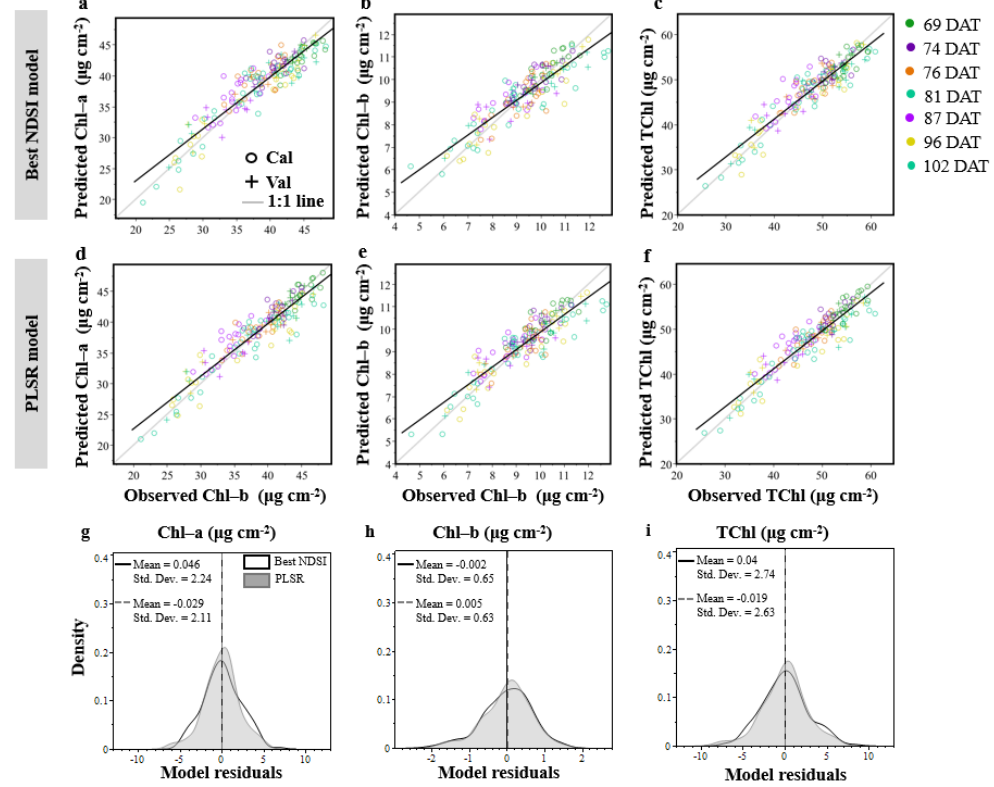
Figure 7. Chlorophyll a (Chl-a), chlorophyll b (Chl-b), and total chlorophyll T(Chl) content estimation by their respective best normalized difference spectral index (NDSI) model and partial least square regression (PLSR) model. Best NDSIs predicted chlorophyll values ( a – c ); PLSR predicted vs. observed chlorophyll values ( d – f ). Solid black lines are best-fit lines, and circle and plus markers represent calibration (Cal) and validation (Val) samples, respectively. DAT stands for days after transplant.